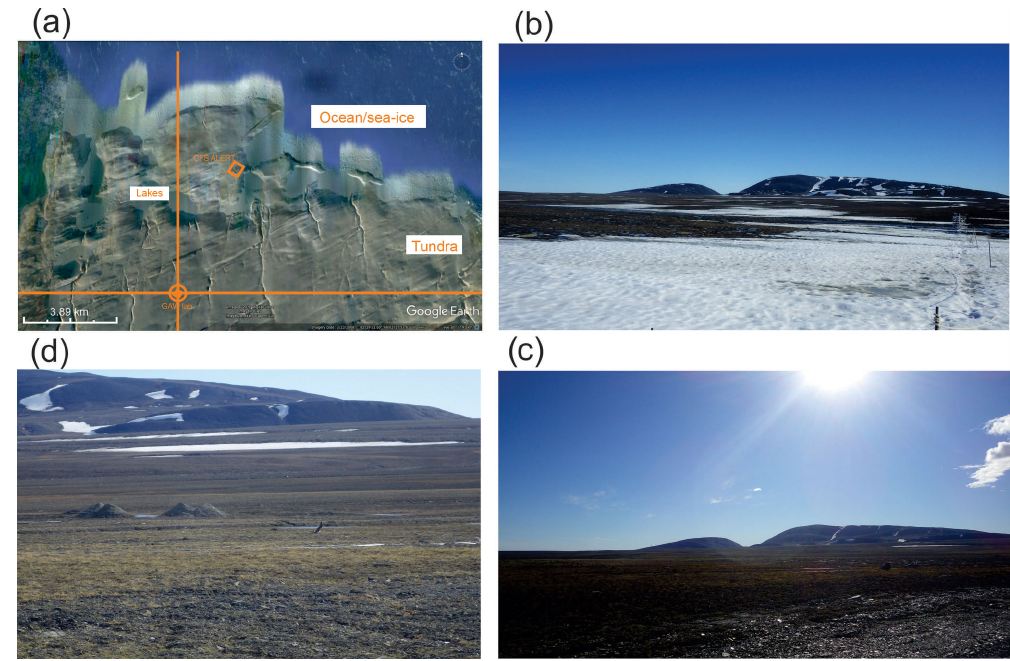
Figure 1. Photographs showing important aspects of the sampling environment. (a) Google Earth photograph showing CFS Alert and the GAW lab. (b) Photograph from the GAW lab in late June 2017 showing the snowpack remnants. (c) Photograph from the GAW lab in early July 2017 showing that all the snow had melted. (d) Characteristic close-up of the surrounding tundra showing the large percentage of bare